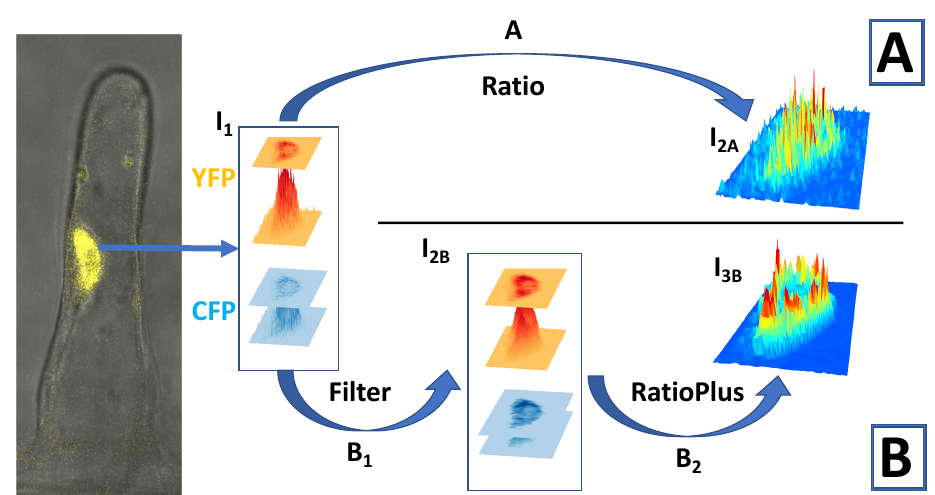
Figure 4. Choices in image processing alter the final ratio image, especially at its edge. The position of a nucleus (yellow) in a M. truncatula root hair is shown in the bright field image of the root hair (grey), merged with the YFP image. Path A shows what happens when images are not processed, while Path B attempts to follow the image processing steps reported in Sieberer et al. [34]. The 2D microscope image of the YFP and CFP intensities at the nucleus reflects the 3D structure of the nucleus, I 1 and I 2 B . The ratios YFP/CFP of images are I 2 A and I 3 B . We used the nuclear localised Ca 2 + sensor YC2.1.